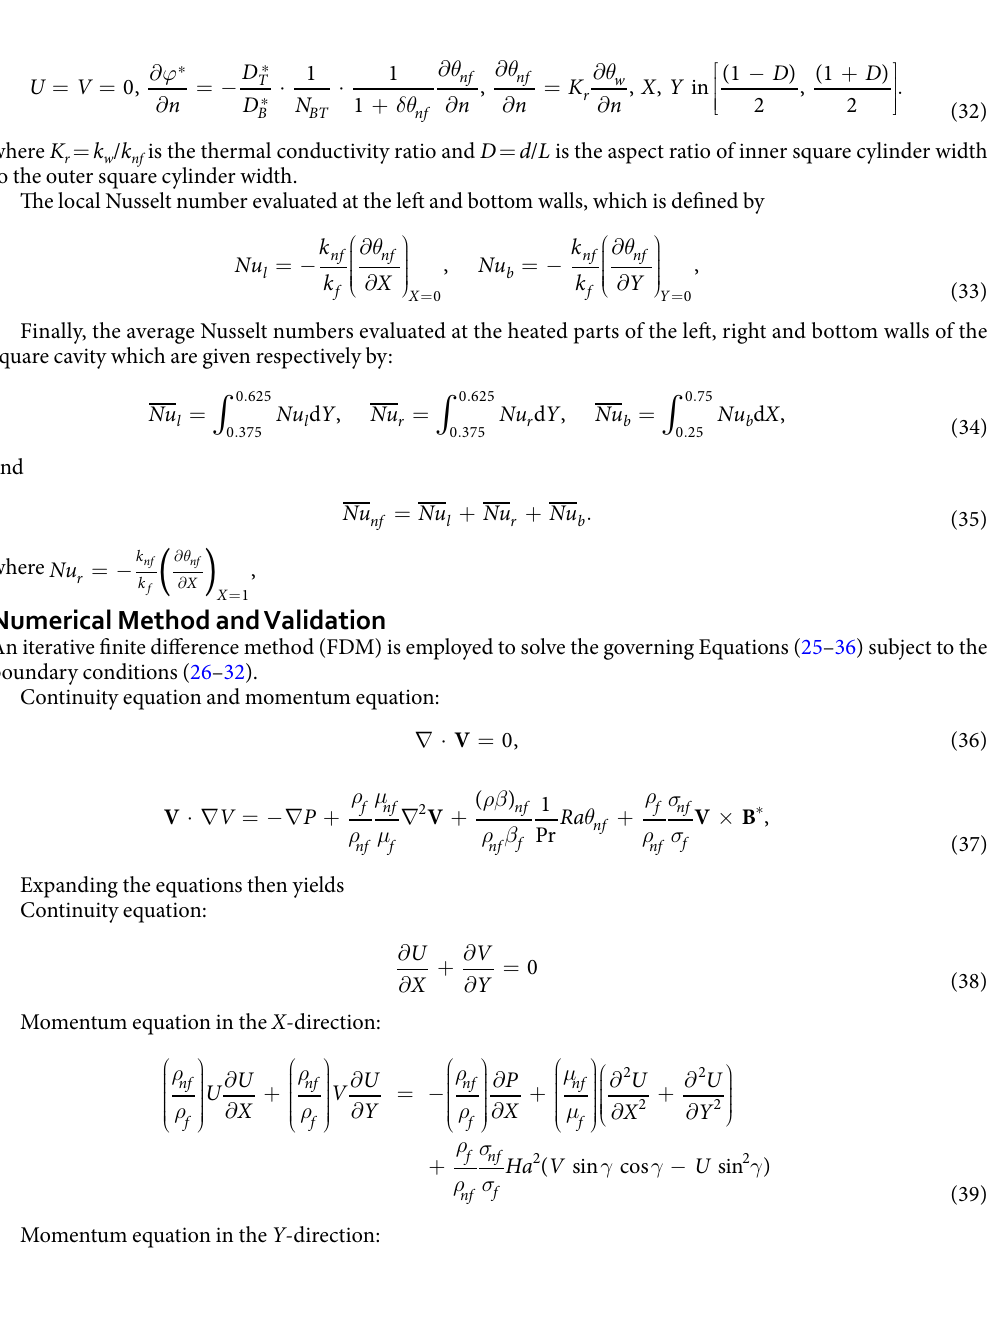
Figure 21. Variation of average Nusselt number with ( a ) Ra and ( b ) φ for different D at Ha = 15 and k w =